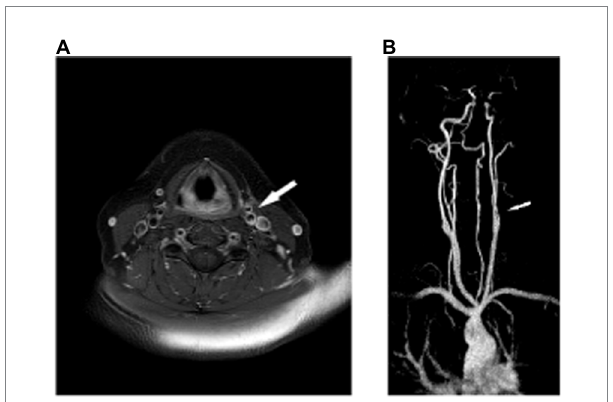
FIGURE 3 (A) Postoperative MR T1-weighted axial image of the neck with fat suppression after contrast medium administration at the level of CCA bifurcation with evidence of no mass. (B) Postoperative contrast contrast-enhanced MR angiography (CE-MRA) of the neck, maximum intensity projection (MIP) reconstruction in the coronal plane with evidence of no pathological vascularization. Only mild irregularities of CCA branches were demonstrated with no significant stenosis.